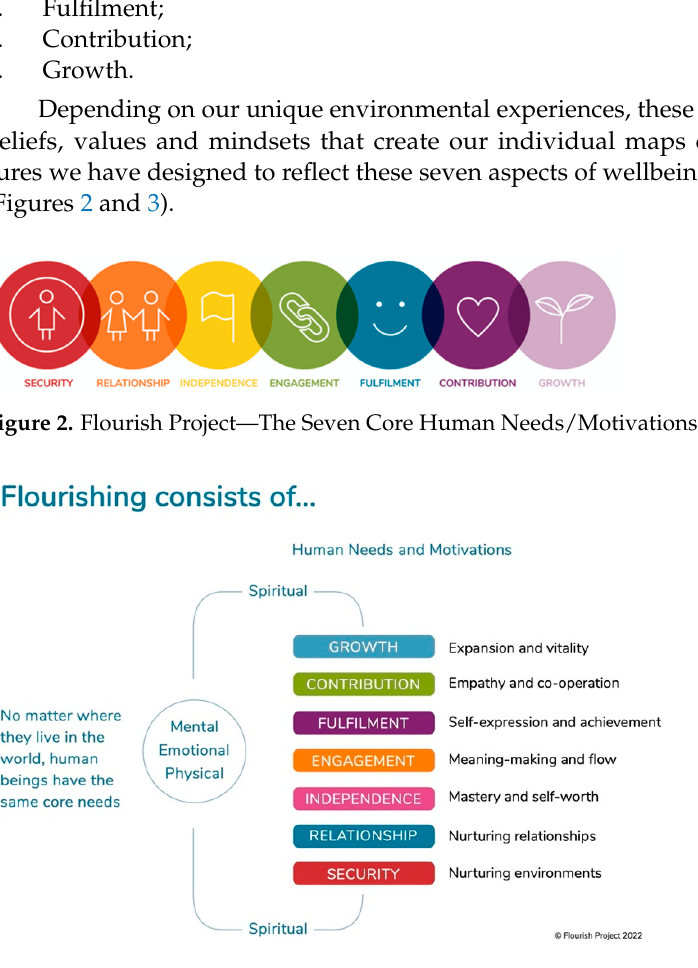
Figure 4. Flourish Project—The Wellbeing Wheel. Not only that, but we are further embedded within the natural world and there is a relational ‘ecological self’ that needs to be recognised and better understood. The construct of the ecological self is illustrated below (Figure 5).